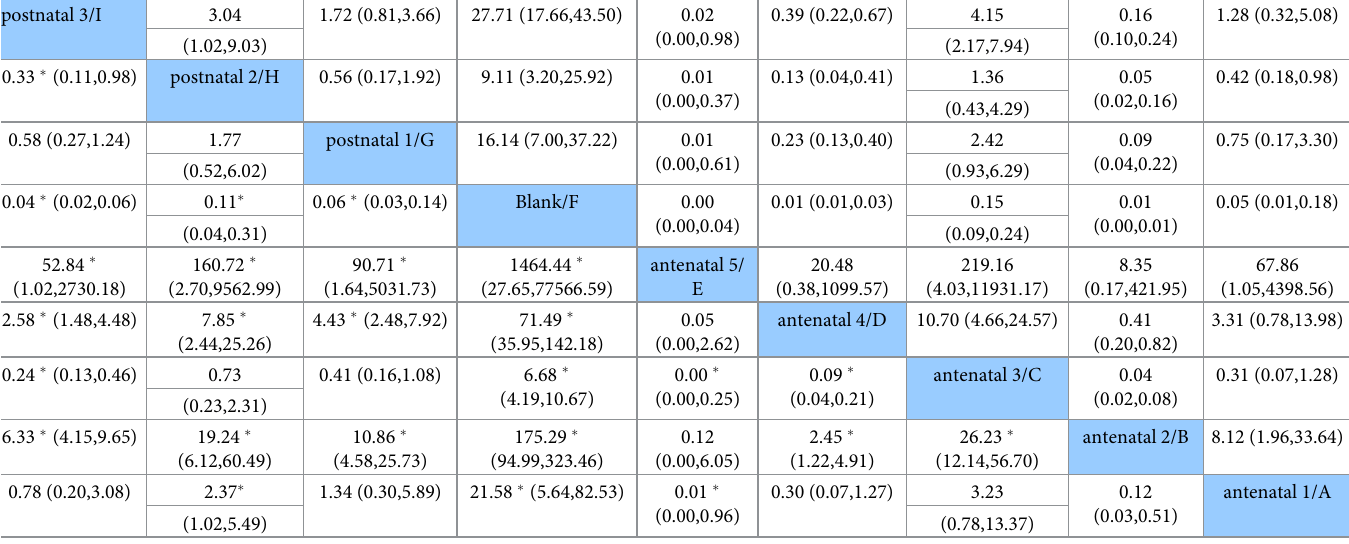
Table 4. Network meta-analysis result.